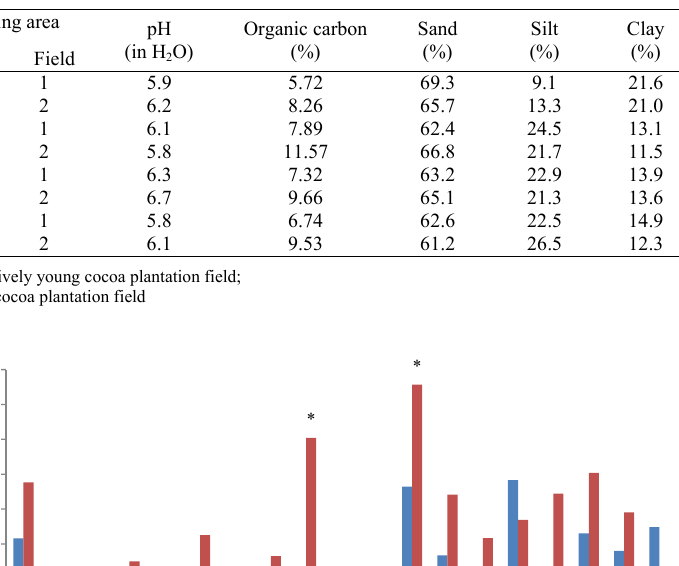
Table 1: Physico-chemical properties of soil of the study area